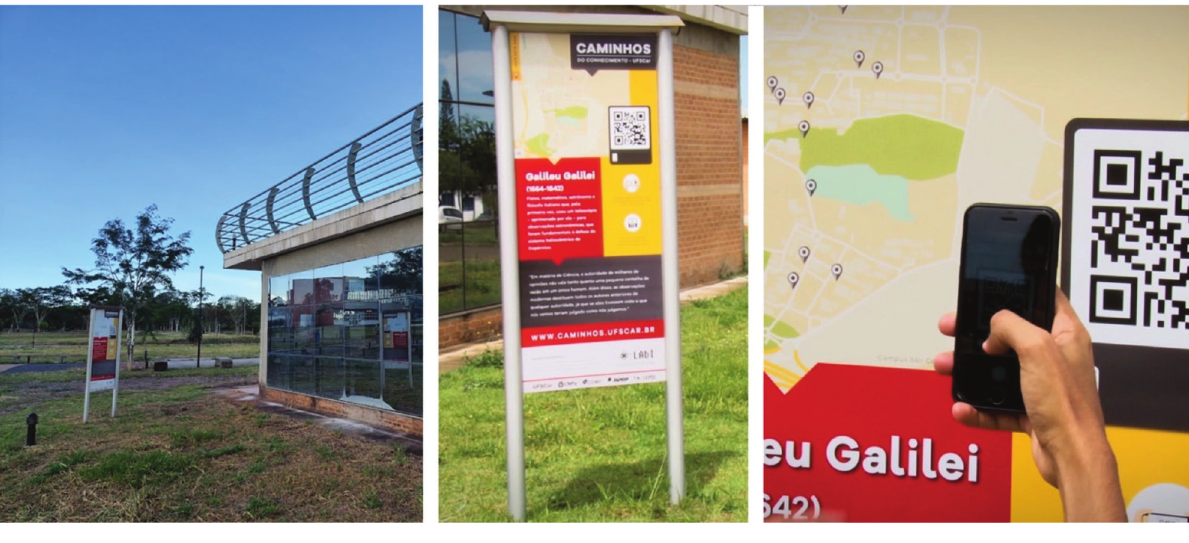
Figure 1. Point Galileo Galilei, located near the Astronomical Observatory of the Federal University